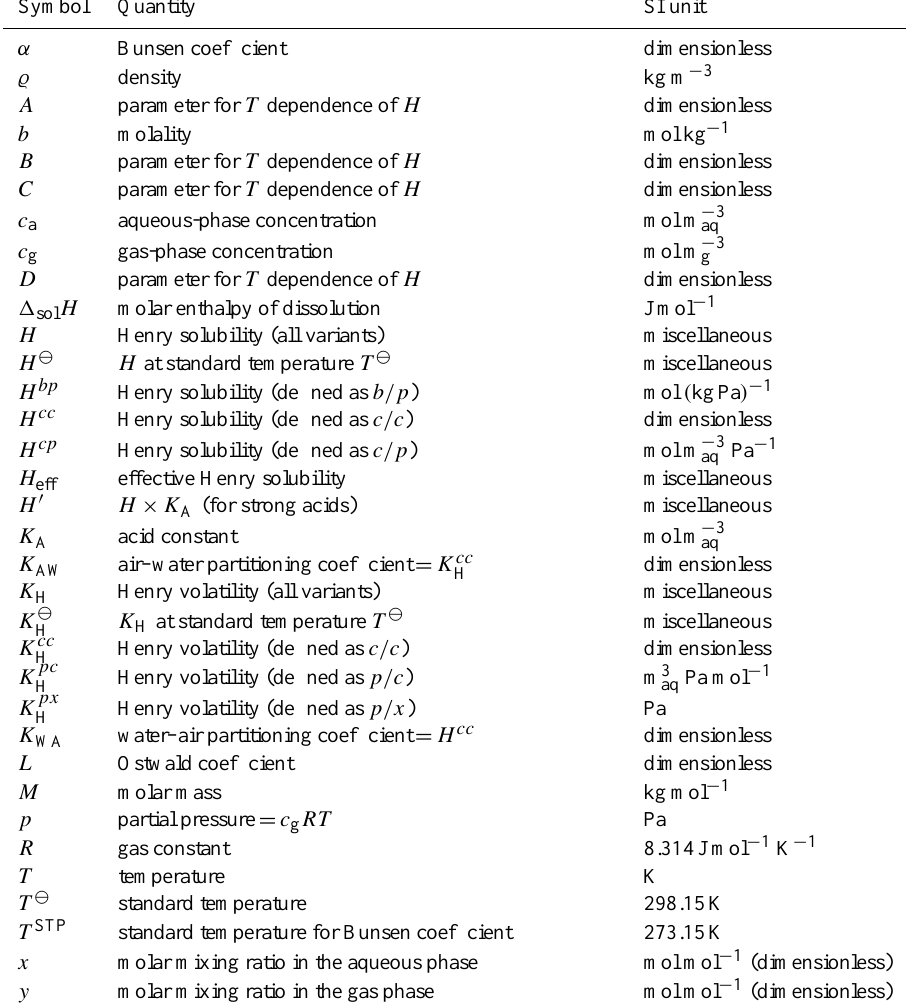
Table 4. List of